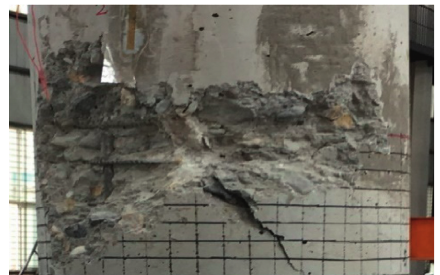
Figure 23: Damage condition of S